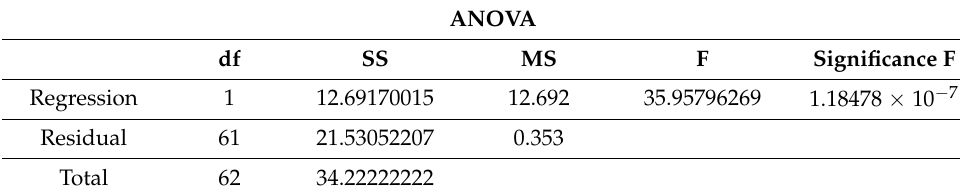
Table 9. ANOVA of the simple regression analysis.